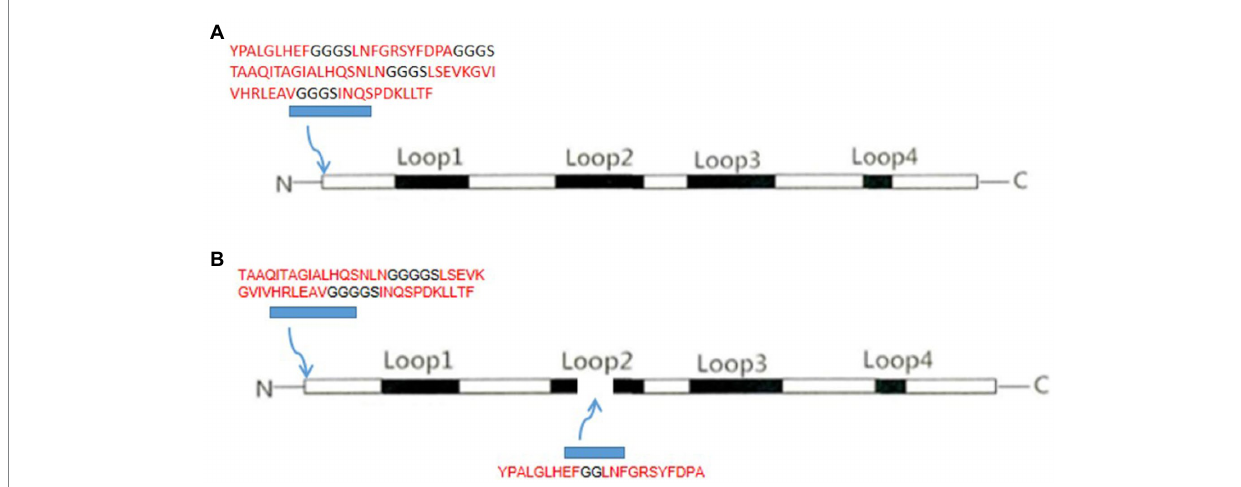
FIGURE 1 Schematic representation of (A) VP2N chimeric construct showing the insertion of CDV epitopes at the 5 ′ end of the CPV VP2 protein and (B) VP2L construct with CDV insertion epitopes both at the 5 ′ end and in the middle of CPV VP2